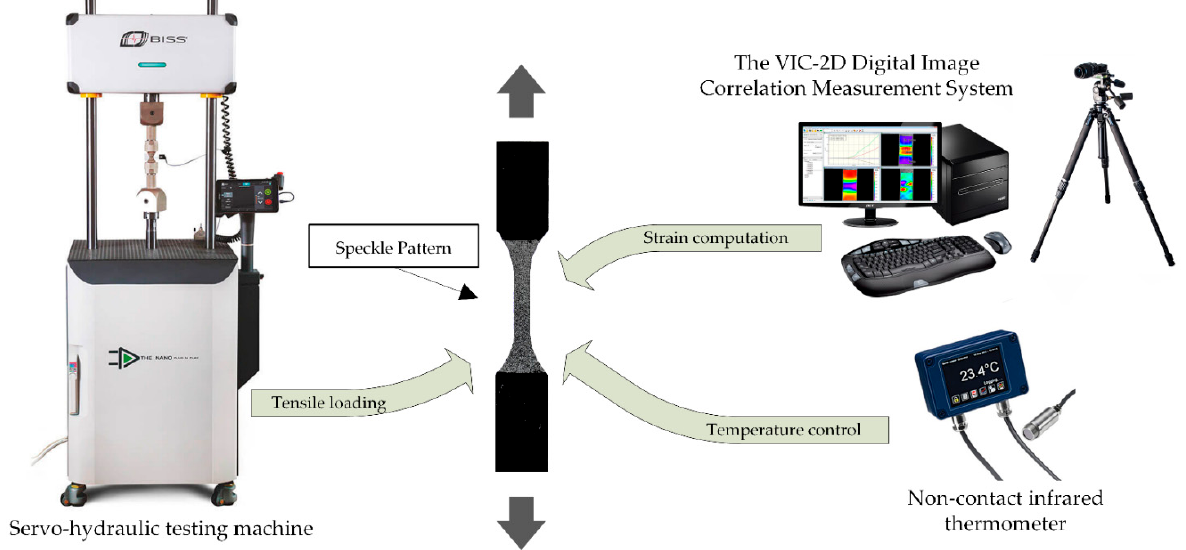
Figure 2. Experimental setup. Non-contact strains measurement during the static tests was carried out by the Digital Image Correlation (DIC) method [37] using a “VIC 2D” facility (Correlated Solutions Inc., Columbia, SC,